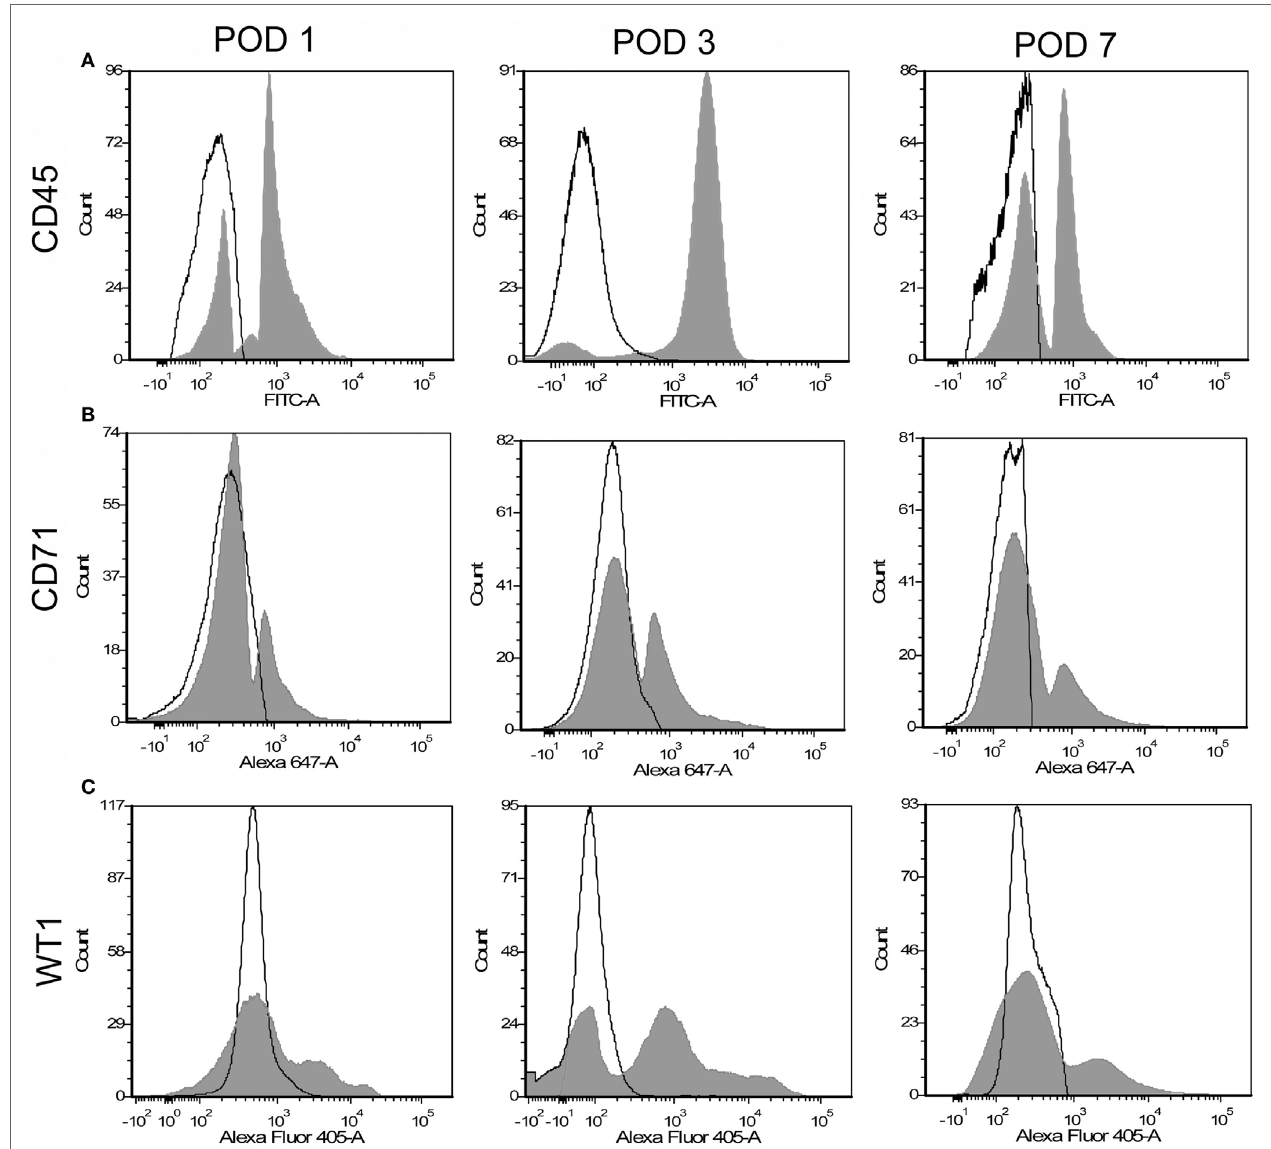
FigUre 4 | Flow cytometry profile of pleural fluid cells after surgical resection. Representative single parameter histograms of CD45 + (a) , CD71 + (B) , and WT1 + (c) cells at three time points after surgery: postoperative days (POD) 1, 3, and 7 (gray). Negative controls (white) reflect samples without detection